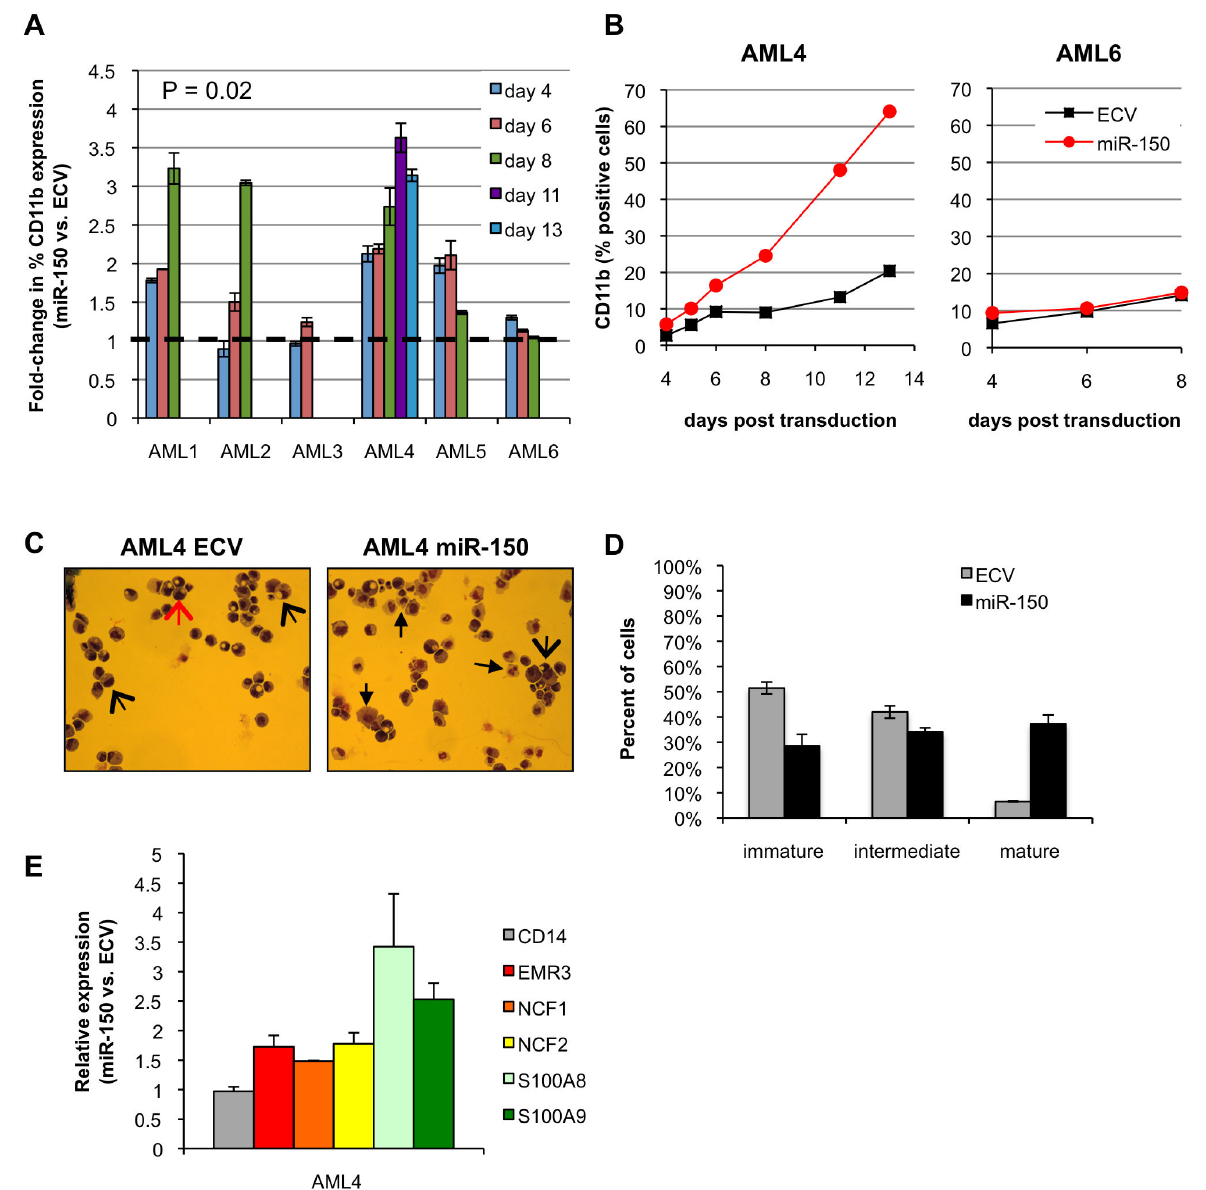
Figure 4. MiR-150 expression induces myeloid differentiation in primary AML cells. Six primary AML patient samples were transduced with pre-miR-150 or empty control lentiviral (ECV) supernatants, sorted for GFP expression, and then assayed by flow cytometry (performed in duplicate) for CD34 and CD11b expression or colony formation by colony-forming unit (CFU) assays. Cells were assessed in presence of rhSCF, rhIL3, rhIL6, rhGCSF, and rhGMCSF (50 ng/ml each) (A) The fold-change increase in CD11b expression in miR-150 expressing cells vs. control cells is displayed individually for 6 AML patient samples. The dotted line indicates the expectation if no change is observed (one sample t-test, P=0.02). (B) Two representative AML patient sample examples of CD11b expression (% positive cells) over time. (C) MiR-150 vs. ECV AML4 patient cells were stained with Wright-Giemsa 12 days after transduction. Arrows indicate immature cells (large red arrows), intermediate differentiated cells (large black arrows), and mature myeloid cells (small black arrows). (D) The following 3-group strategy was used to quantitate cells in various stages of myeloid differentiation: blasts (immature); myelocytes, metamyelocytes, and promonocytes (intermediate); band cells, neutrophils, and monocytes (mature). Percentage of cells in each stage of differentiation displayed as an average of 10 fields (400 cells counted), error bars indicate standard deviations. (E) Expression of genes associated with myeloid differentiation was assessed in AML4 primary cells 9 days after transduction by QPCR. Relative fold-difference in expression for miR-150 vs. ECV cells is displayed; error bars represent standard deviations of technical triplicates. doi: 10.1371/journal.pone.0075815.g004 PLOS ONE |